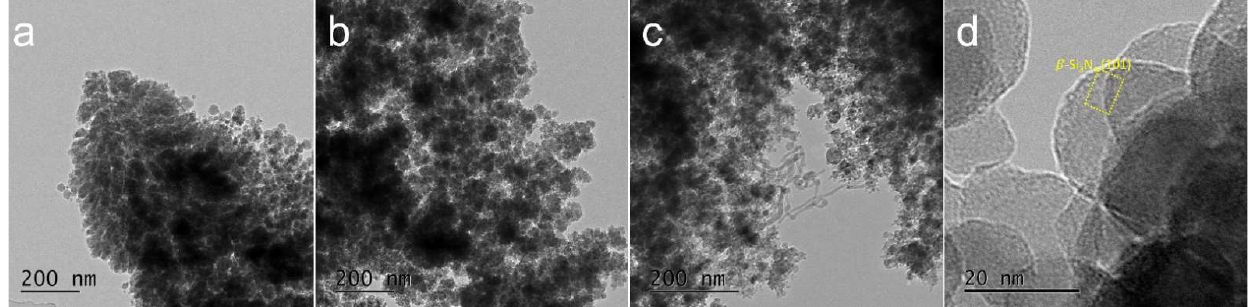
Figure 5. FE-transmission electron microscopy (TEM) images of nanopowder synthesized in ( a ) Run 2, ( b ) Run 3, and ( c , d ) Run 4.